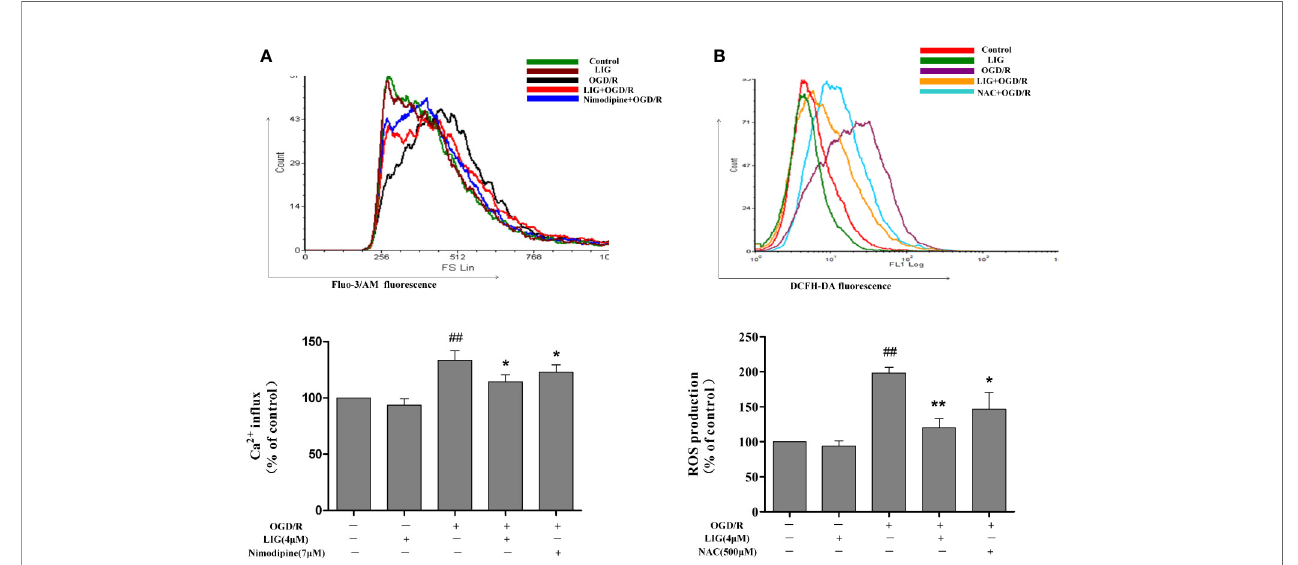
FIGURE 2 | Ligustilide (LIG) attenuated Ca 2+ in fl ux and reactive oxygen species (ROS) levels in oxygen-glucose deprivation/reperfusion (OGD/R)-induced hippocampal neurons injury. ( A) Effect of ligustilide on OGD/R-stimulated intracellular Ca 2+ in fl ux. (B) Effect of ligustilide on OGD/R-induced ROS overproduction. Cells were treated with LIG (1, 2, and 4 m M) for 3 h, and then subject to OGD/R. Fluo-3/AM and DCFH-DA were used to measure Ca 2+ in fl ux and ROS levels. The data are represented as means ± SD for three independent experiments. Each of the experiments was repeated three times. The data are means ± SD. ## P < 0.01 vs. control group; * P < 0.05, ** P < 0.01 vs. group treated with